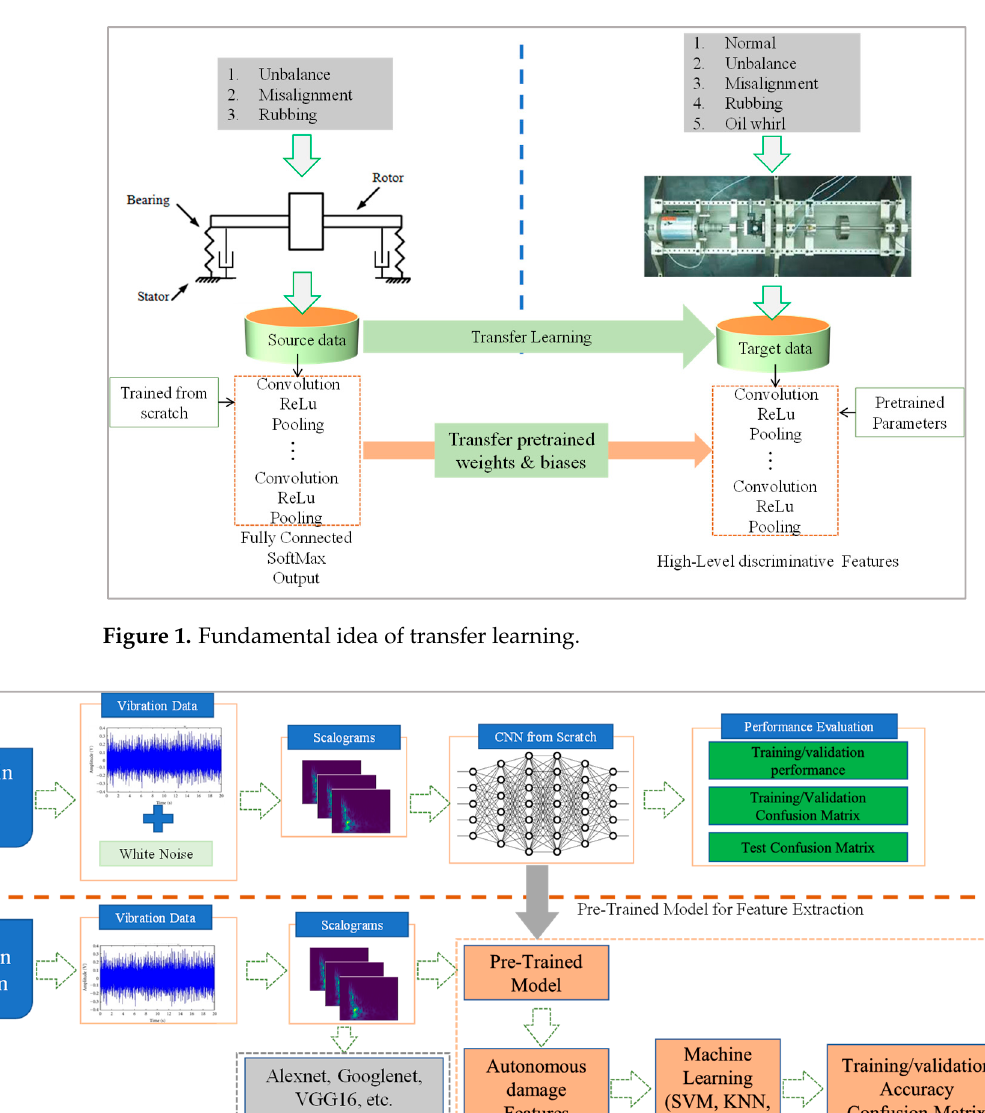
Figure 1. Fundamental idea of transfer learning.